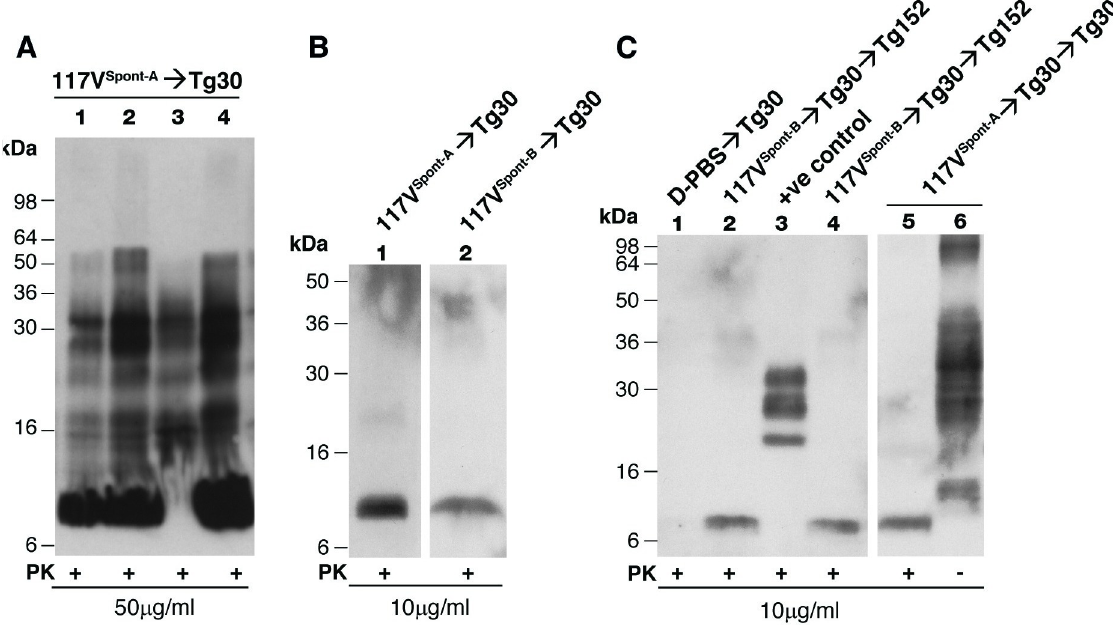
Fig 5. Immunoblot detection of disease-related PrP in transgenic mouse brain. Panels A–C show transgenic mouse brain homogenates (10% (w/v) in D-PBS) analysed with anti-PrP monoclonal antibody ICSM 35 (epitope human PrP residues 93–105) and high-sensitivity chemiluminescence either before ( − ) or after (+) digestion with PK. The provenance of each brain sample is designated above each lane. Brain homogenates analysed in panel A underwent only 1 freeze/thaw cycle prior to analysis whereas those in panels B and C underwent 2 freeze/thaw cycles prior to analysis. (A) Primary transmission of spontaneous 117V prion isolate from 117V Spont-A mouse brain to 117VV Tg30 mice. Classical proteolytic fragments of PrP Sc (akin to PrP 27–30; lanes 1–4) and an 8 kDa PrP fragment (together with possible multimers thereof migrating at 16–18 and 22–23 kDa [32]; lanes 1, 2, and 4) are seen in brain homogenates that have not undergone repetitive freeze/thaw cycles prior to PK digestion. This pattern of disease-related PrP fragments is closely similar to the pattern seen in the brain of 117VV mice following primary transmission of IPD A117V prions from patient brain [30]. (B) Primary transmission of spontaneous 117V prion isolates from 117V Spont-A and 117V Spont-B mouse brain to 117VV Tg30 mice. Brain homogenates that underwent repetitive freeze/thaw cycles prior to digestion with PK show only an 8 kDa PK-resistant PrP fragment. (C) Secondary transmission of spontaneous 117V prion isolates. Spontaneous 117V prion isolates from 117V Spont-A and 117V Spont-B mouse brains were passaged once in 117VV Tg30 mice and brain homogenates from these transmissions used to inoculate further 117VV Tg30 mice or 129VV Tg152 mice. Subclinically affected mice from these secondary transmissions show an 8 kDa protease-resistant PrP fragment in brain homogenates that underwent repetitive freeze/thaw cycles prior to PK-digestion (lanes 2, 4, and 5). Lane 1 shows brain homogenate from a negative control 117VV Tg30 mouse inoculated with D-PBS. Lane 3 shows brain homogenate from a positive control 129MM Tg35 mouse propagating sporadic CJD prions, and lane 6 shows analysis of the same brain as lane 5 in the absence of PK digestion. CJD, Creutzfeldt-Jakob disease; ICSM, Imperial College School of Medicine; IPD, inherited prion disease; PK, proteinase K; PrP, prion protein.